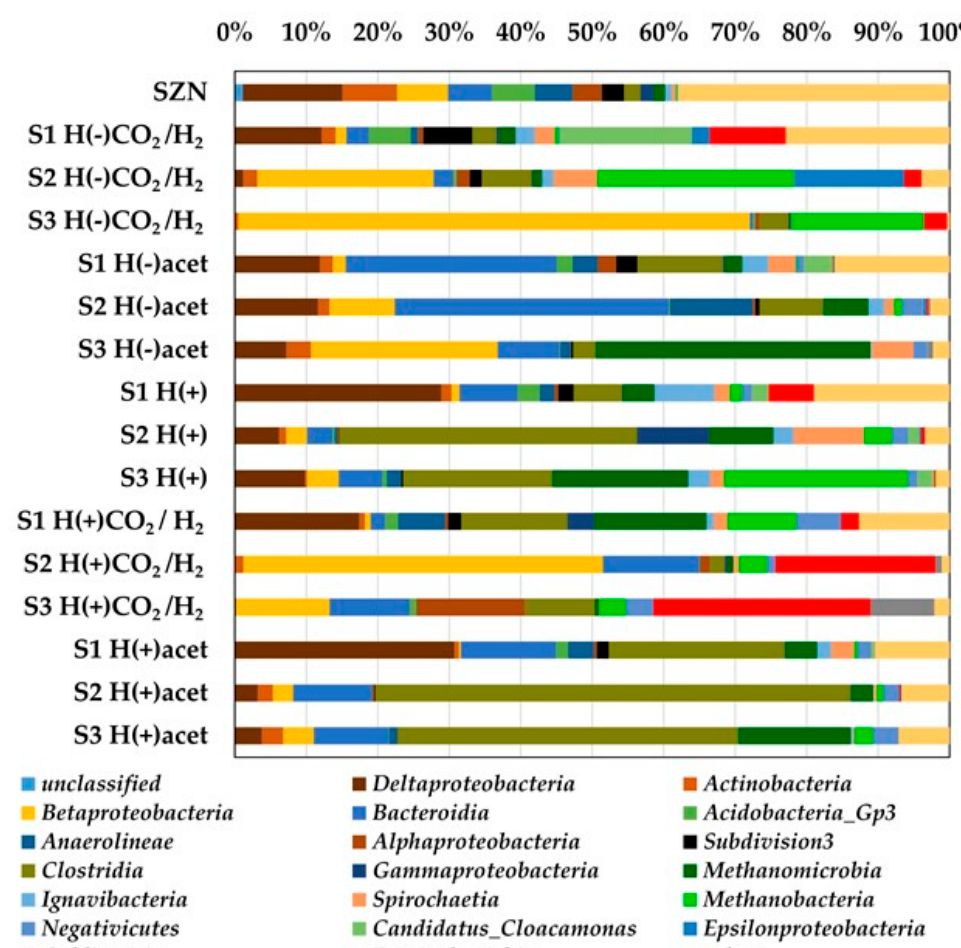
Figure 4. Diversity in the microbial communities at the class level (microbial classes represented by >2% of total sequences, classes making up less than 2% were classified as others) in response to the different media composition and in the particular stage of enrichment identified by 16S rRNA gene sequences.